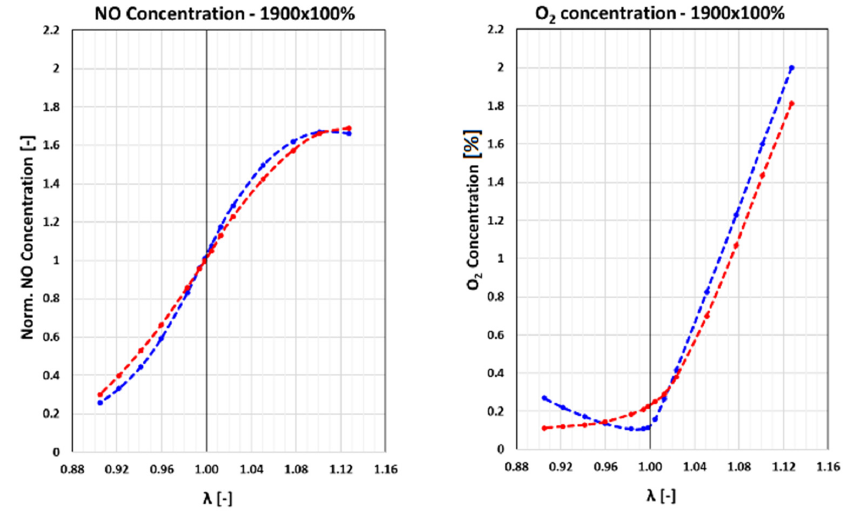
Figure 11. NO, CO, CO 2 and O 2 engine-out concentration; comparison between predicted and experimental data during λ variations.